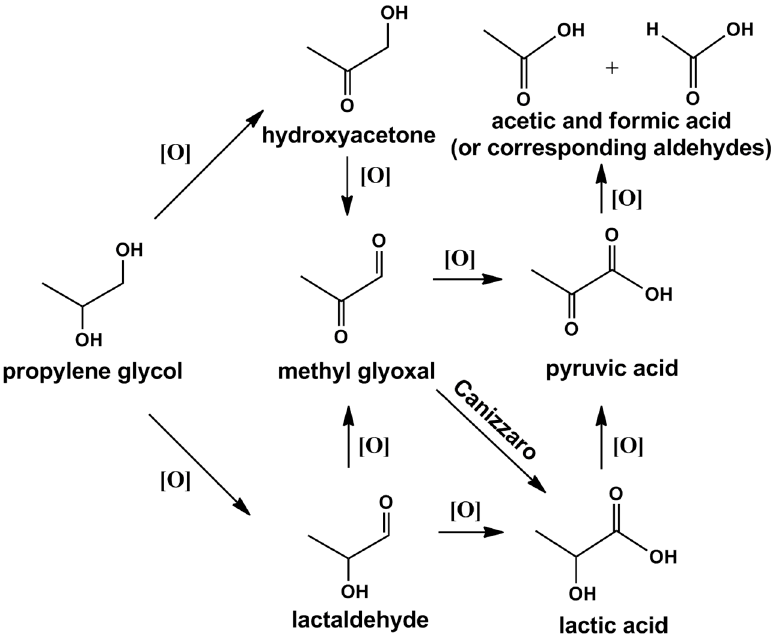
Figure 18. Oxidative transformations of PG. Reprinted with permission from reference [138].